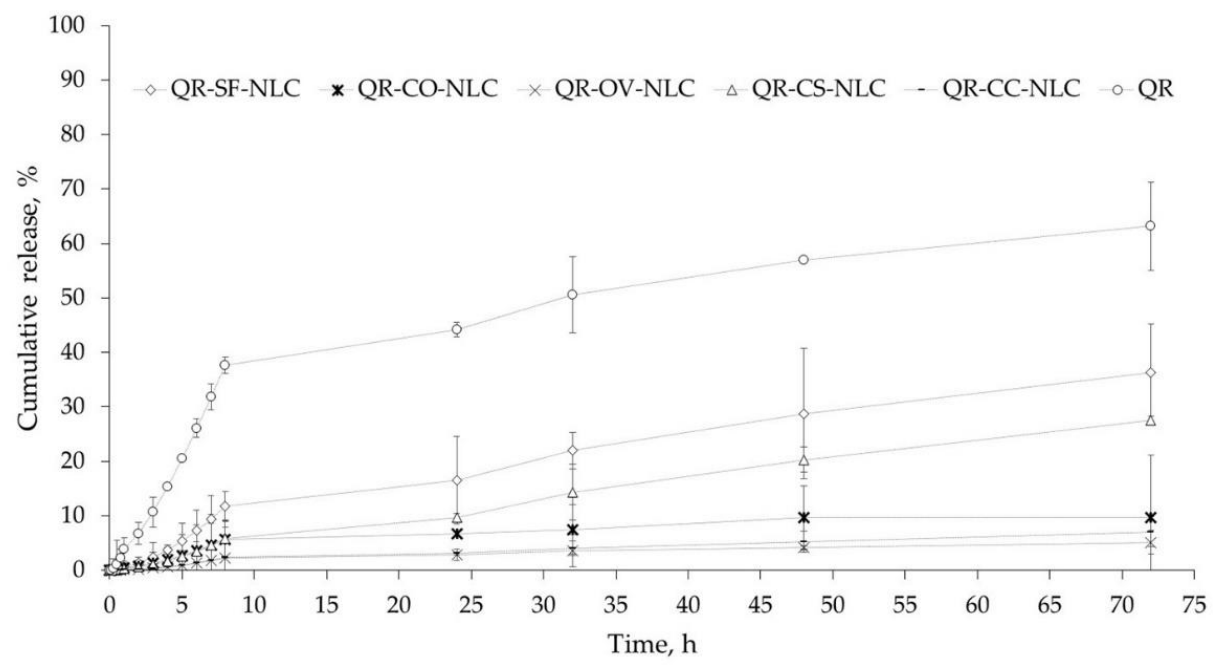
Figure 6. Release profiles of QR-NPO-NLC from the optimized lipid nanocarriers with 0.5% of QR and free quercetin solutions (2.5 mg mL − 1 in propylene glycol).